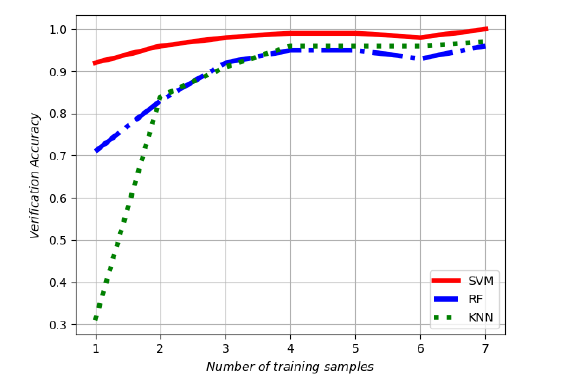
Figure 13. Accuracy curves of support vector machine (SVM), random forest (RF), and K-nearest neighbour (KNN) classifiers in the contact-based Hong Kong Polytechnic University Palmprint (HKPU) database.